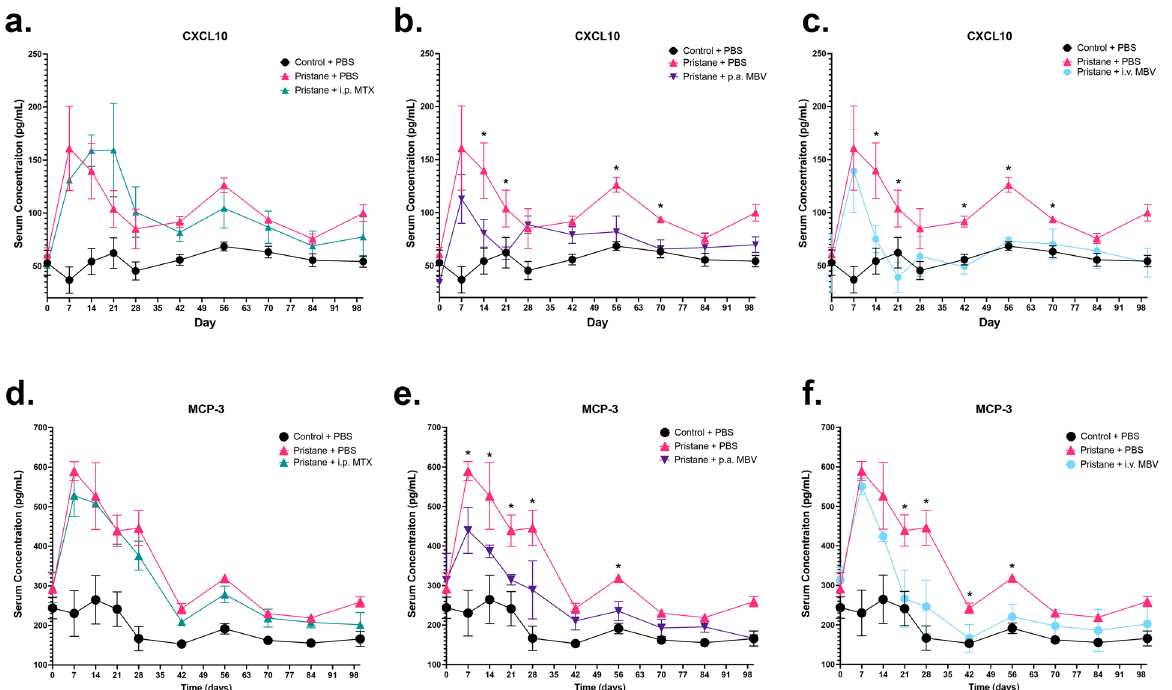
Fig. 3 Local and systemic administration of MBV decrease the concentration of RA-associated, pro-in fl ammatory chemokines CXCL10, and MCP-3 in both the acute and chronic phases of disease. a Serum concentration of CXCL10 does not differ between Pristane + PBS and Pristane + i.p. MTX groups in the acute and chronic phases of pristane-induced arthritis ( p > 0.05). b P.a. MBV decreases serum concentration of CXCL10 in both the acute and chronic phase of pristane-induced arthritis ( p < 0.05). c I.v. MBV decreases serum concentration of CXCL10 in both the acute and chronic phase of pristane-induced arthritis ( p < 0.05). d Serum concentration of MCP-3 does not differ between Pristane + PBS and Pristane + i.p. MTX groups in the acute and chronic phases of pristane-induced arthritis ( p > 0.05). e P.a. MBV decreases serum concentration of MCP-3 in both the acute and chronic phase of pristane-induced arthritis ( p < 0.05). f I.v. MBV decreases serum concentration of MCP-3 in both the acute and chronic phase of pristane-induced arthritis ( p < 0.05). All values in panels a – f represent mean ± s.e.m. ( n =